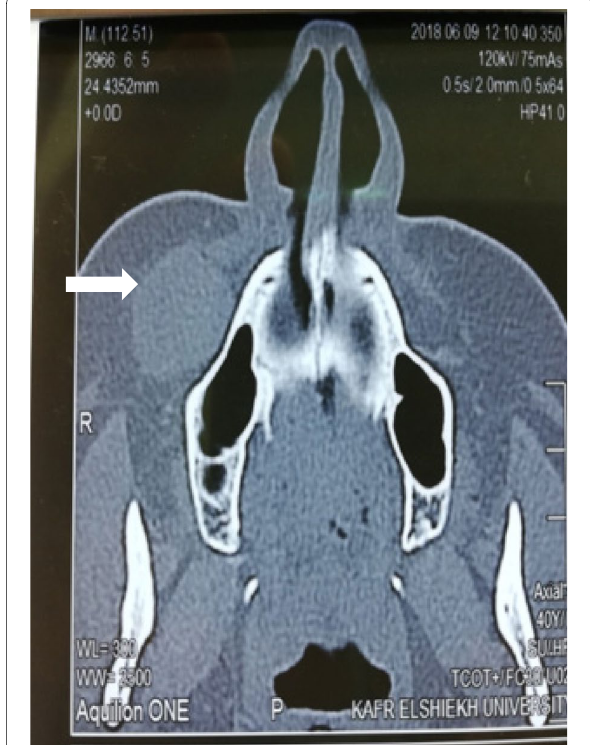
Fig. 1 CT scan nose and PNS axial section: showing well-defined lesion in the right buccal space. The white arrow points out to the lesion